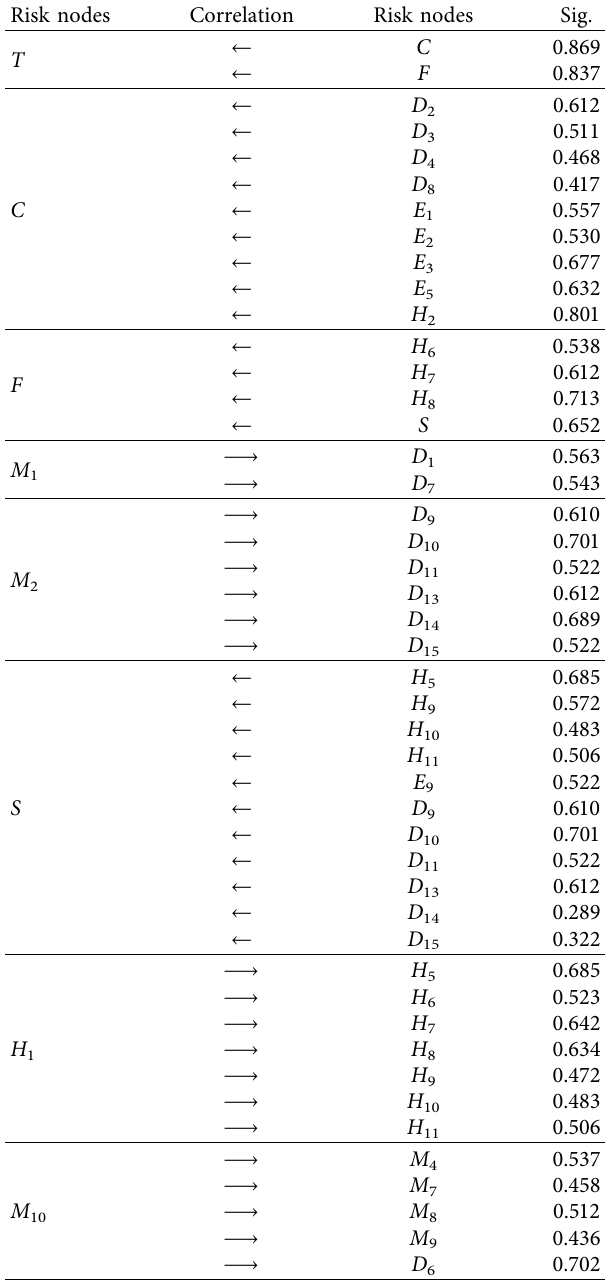
Table 2: Main cause nodes of gas explosion. Risk